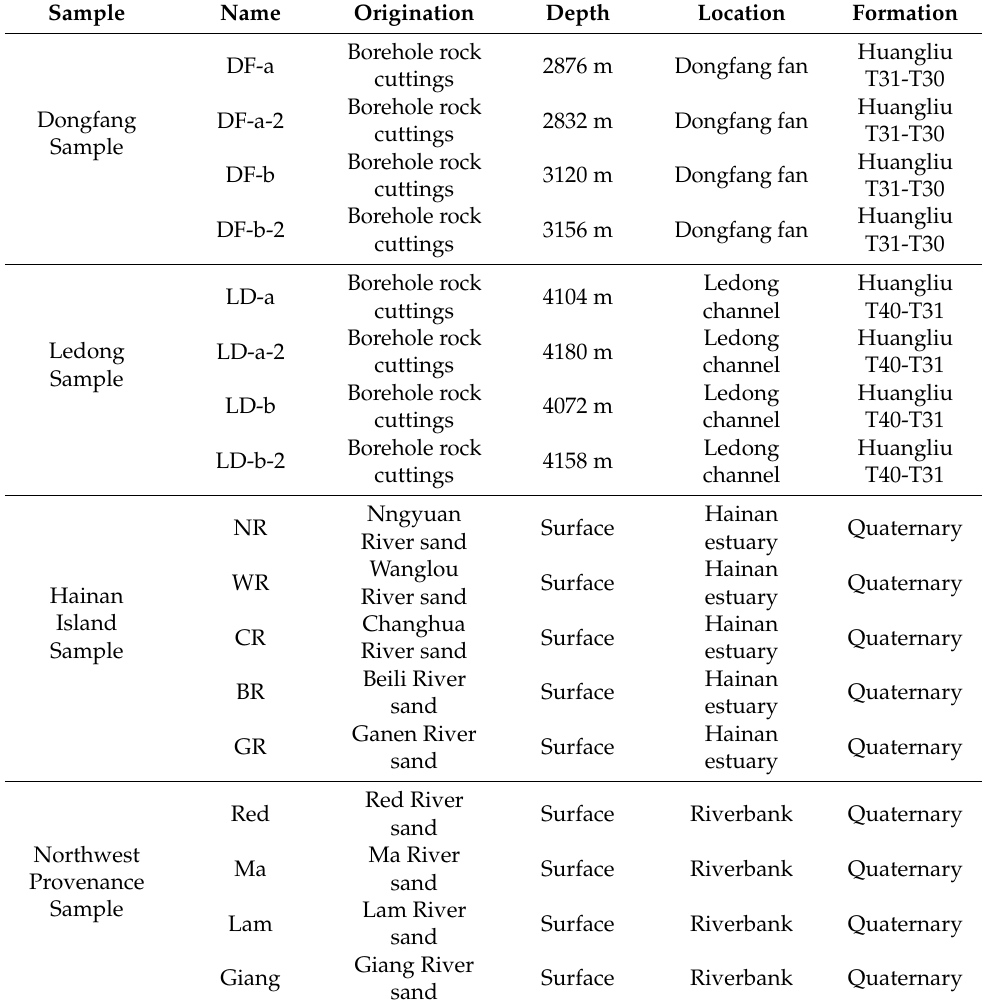
Table 1. Zircon and heavy mineral sample